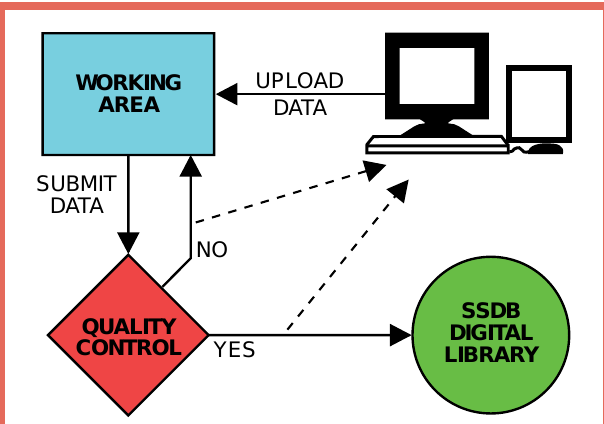
Figure 2. Schematic of data fl ow into the SSDB Digital Library. A proponent uploads digital data fi les from their computer into the ‘working area’ on the SSDB site, providing appropriate metadata. In the working area, they may review and modify the metadata before submitting the data files and associated metadata to the SSDB for quality control checking (QC). If the fi le pairs are acceptable, they are entered into the Digital Library. If errors are discovered during the QC process, the submissions are moved back into the working area, where the proponent can make needed changes. In both cases, e-mail noti fi cation (dashed line) is sent to the proponent informing them of the QC result.